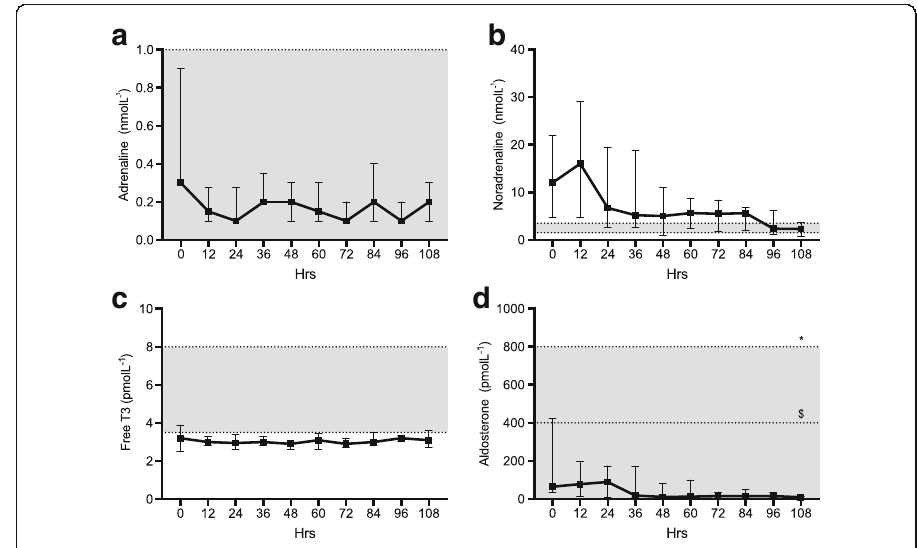
Fig. 5 Hormone profile. Median and interquartile range for each time point. Normal range is represented by the shaded area. a Adrenaline. b Noradrenaline. c FT3. d Aldosterone